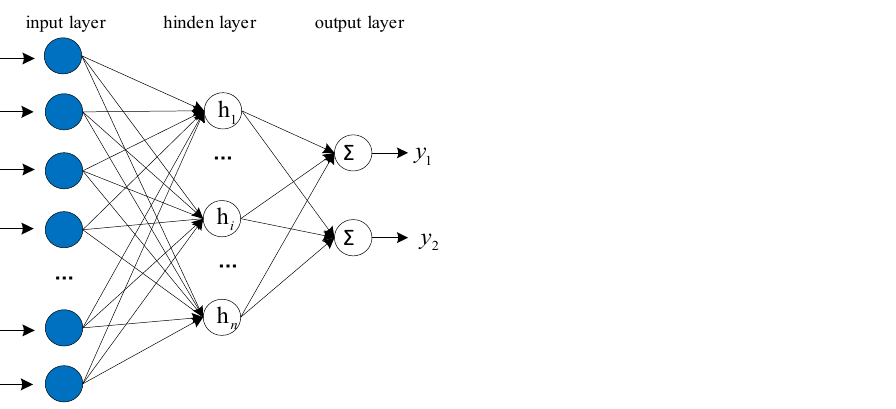
Figure 4. Architecture of RBF neural network to predict tobacco moisture content and temperature.